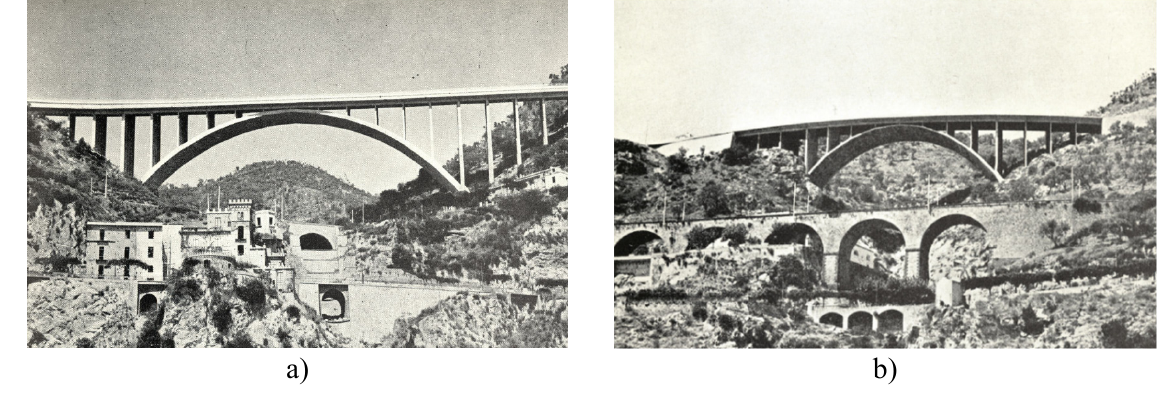
Figure 1. Example of Maillart-Type Arch